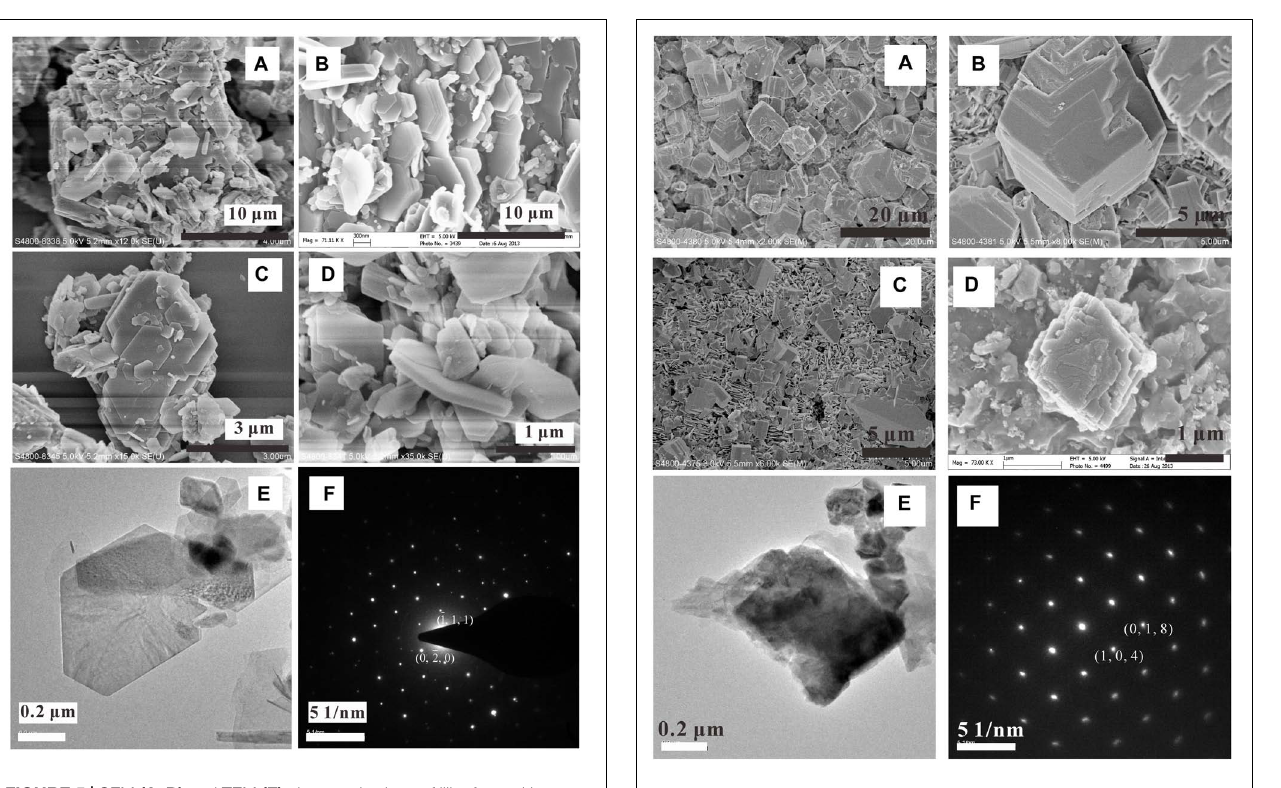
FIGURE 6 | SEM observations of calcite crystals formed in the [H